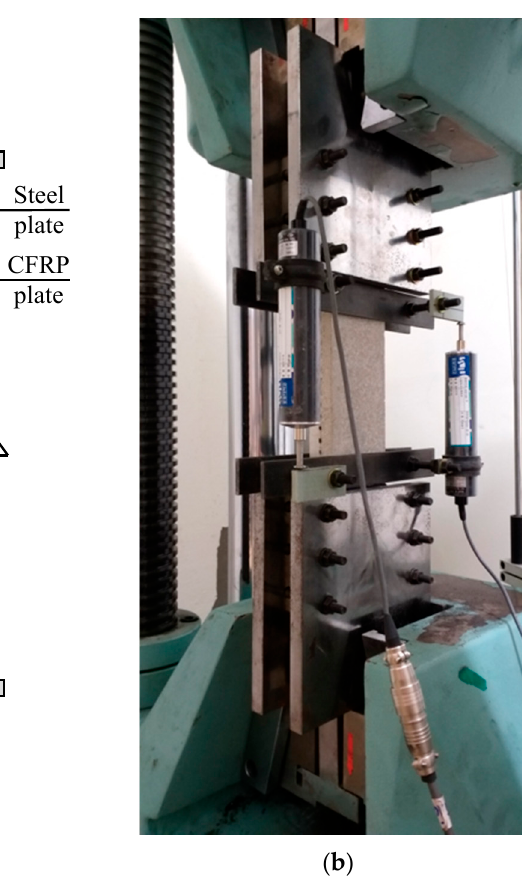
Figure 8. Test setup and measuring instruments: ( a ) schematic of the test setup; ( b ) photograph of the test setup.